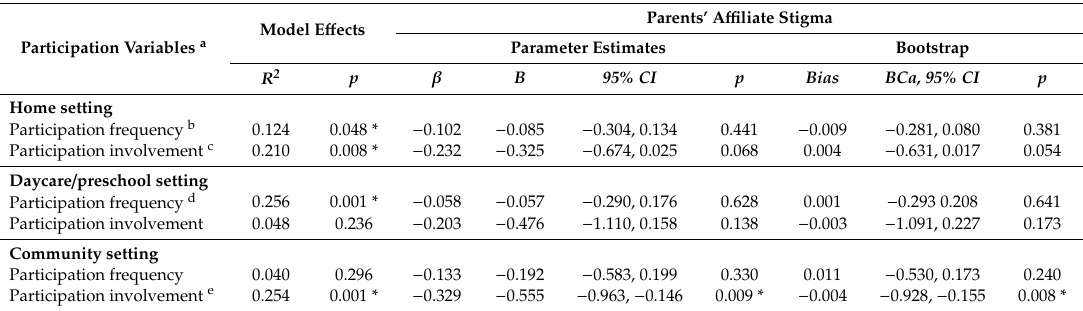
Table 4. Relationships between parents’ a ffi liate stigma and children’s participation after controlling for demographic variables in hierarchical regression